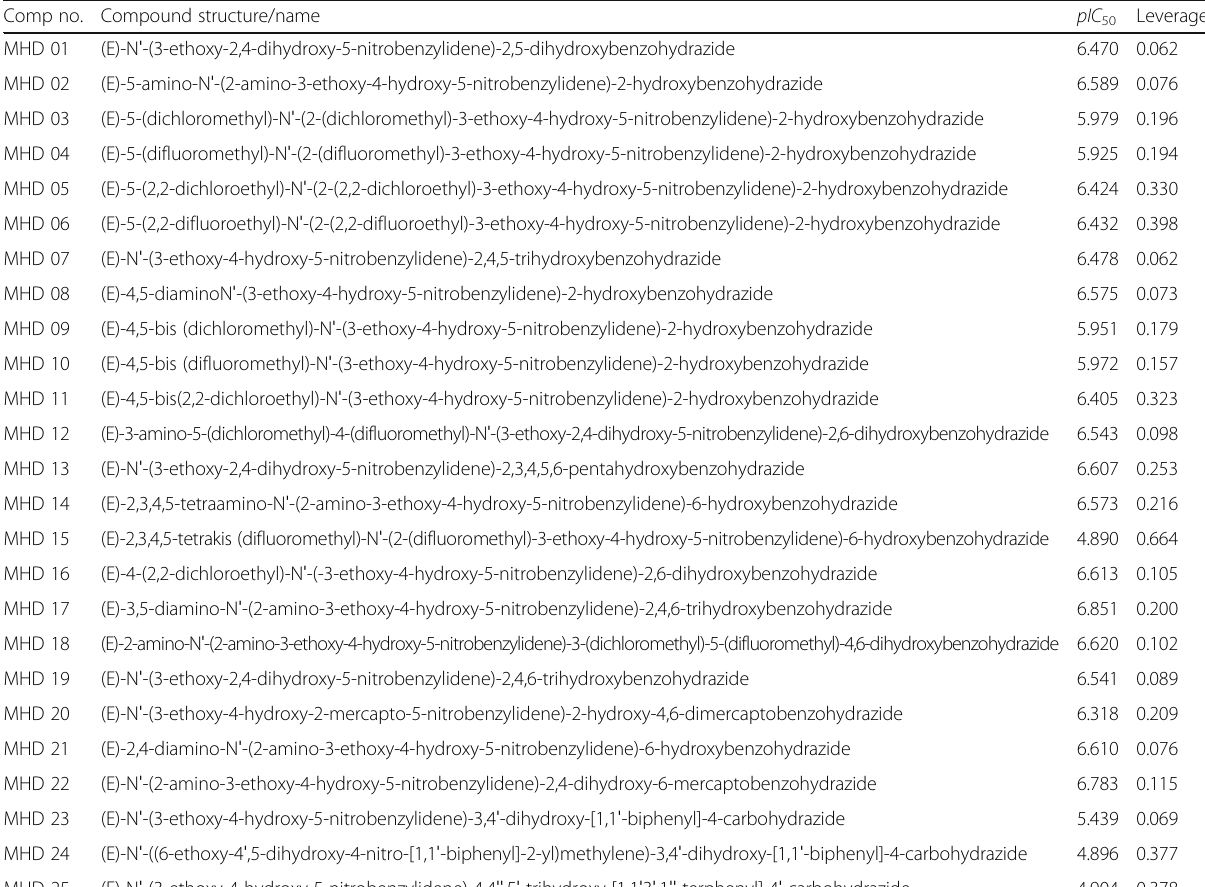
Table 1 Designed hydrazone antioxidants, their predicted antioxidant activities and leverage values Comp no. Compound